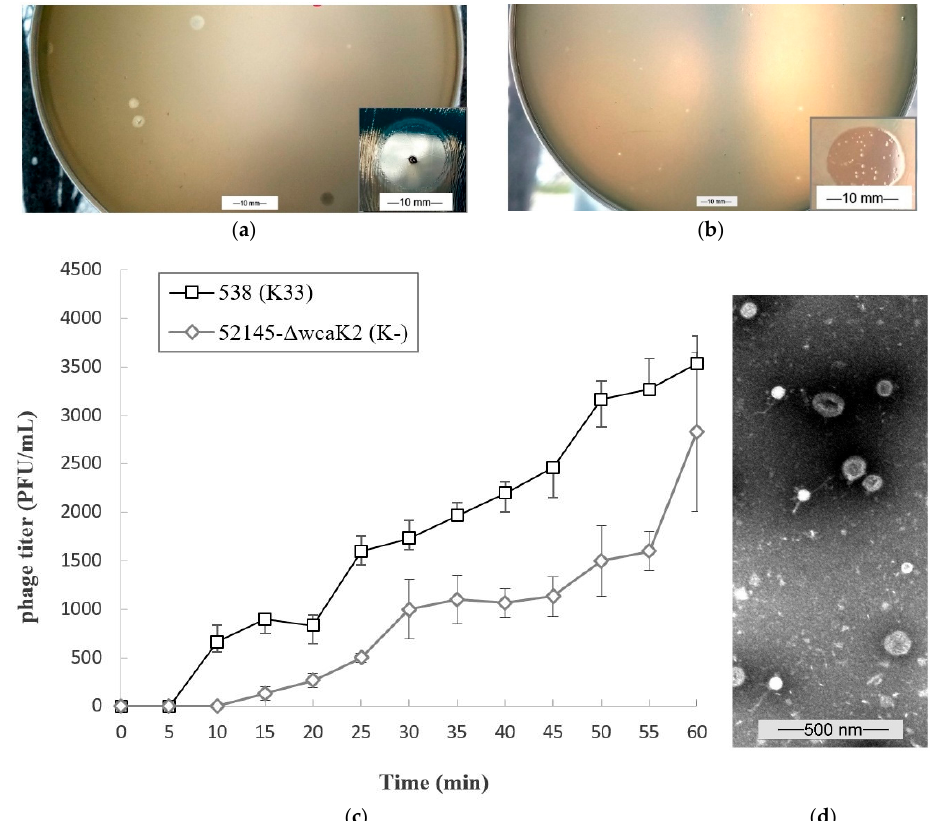
Figure 1. Characteristics of phage 731. ( a , b ) Individual plaques and clear spot (small pictures) on 52145- Δ wca K2 (K-) lawn ( a ) and on 53.8 (K33) lawn ( b ). Individual plaques were acquired by agar overlay method, clear spots were gained by dropping 10 μ L of the concentrated phage suspension. Scale bars represent 10 mm. ( c ) One-step growth curves of phage 731 on the 52145- Δ wca K2 (K-) (gray) and on the 53.8 (K33) strain (black). The titer of the phage at different times are shown. Data are the mean of 3-3 independent experiments, error bars represent ± SD. ( d ) Electron micrograph of phage 731 stained with 1.5 w / v phospho-tungstic acid. Scale bar represents 500 nm.